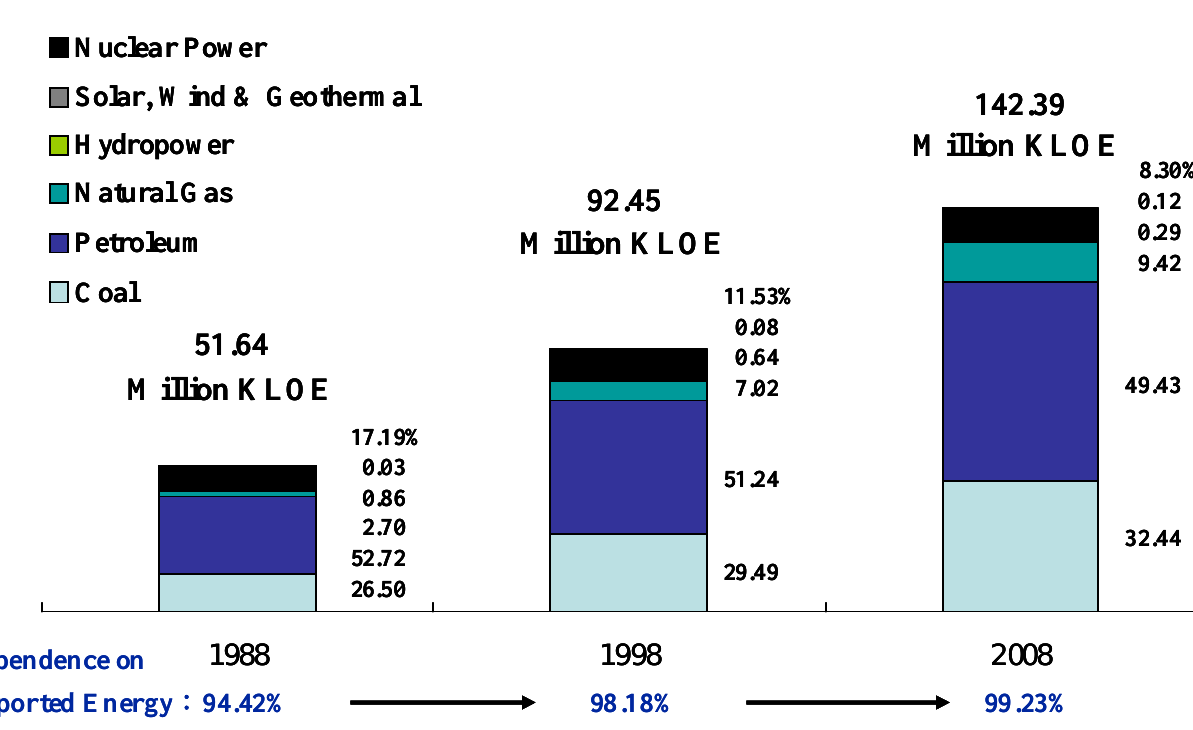
Figure 1. The structure of total energy supply in Taiwan (by Energy Form) [2].